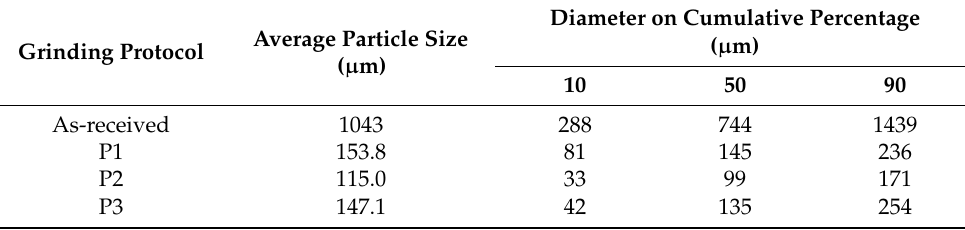
Figure 1. Particle size distribution of as-received and cryo-ground ground tire rubber (GTR) according to different grinding protocols. Table 3. Average particle size and diameter, on cumulative percentage, of the as-received and cryo-ground GTR according to different grinding protocols.